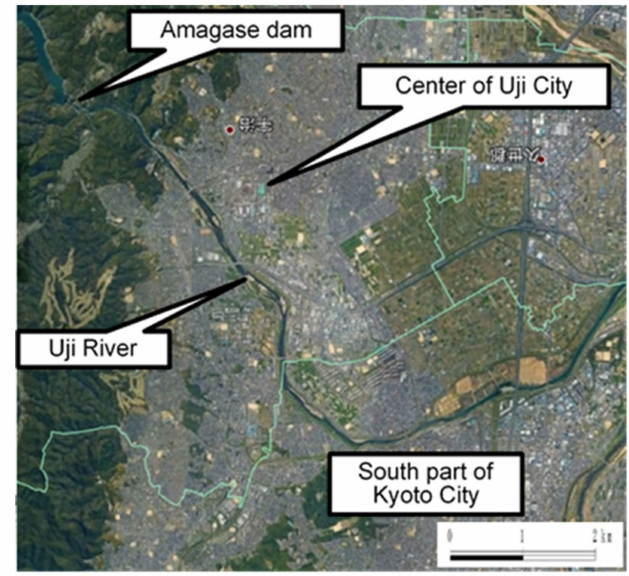
Figure 10. Locations of Amagase Dam and the high-density zone of the population of Uji City (the gray zone is the circumference of “Center of Uji City”).